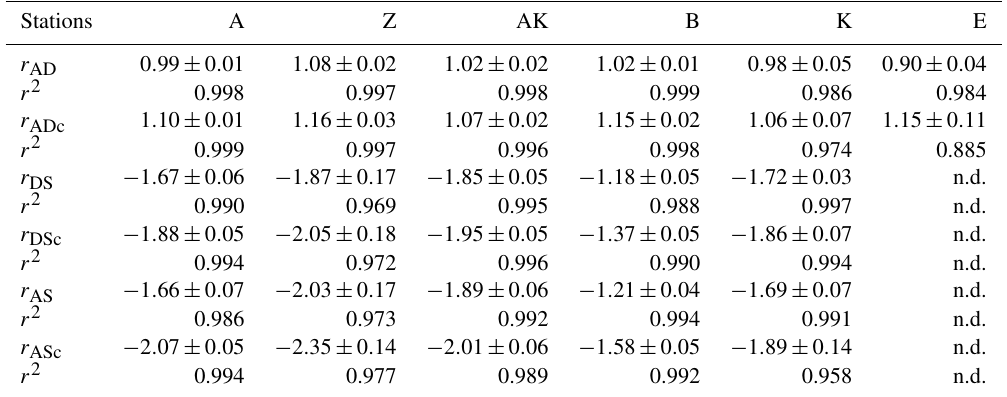
Table 3. Diffusion-corrected stoichiometric ratios r AD , r DS , and r AS and their corresponding ratios corrected for carbonate precipitation ( r ADc , r DSc and r ASc ) along with their associated determination coefficients ( r 2 ) from linear regression (n.d. = not determined).